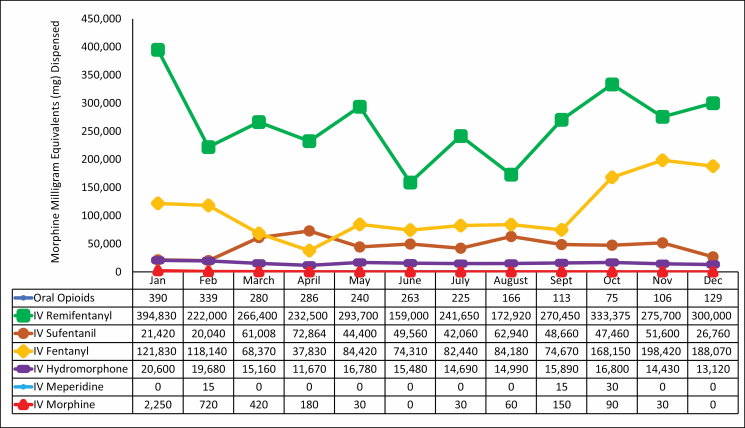
Opioid medications dispensed to operating rooms (ORs) in 2018